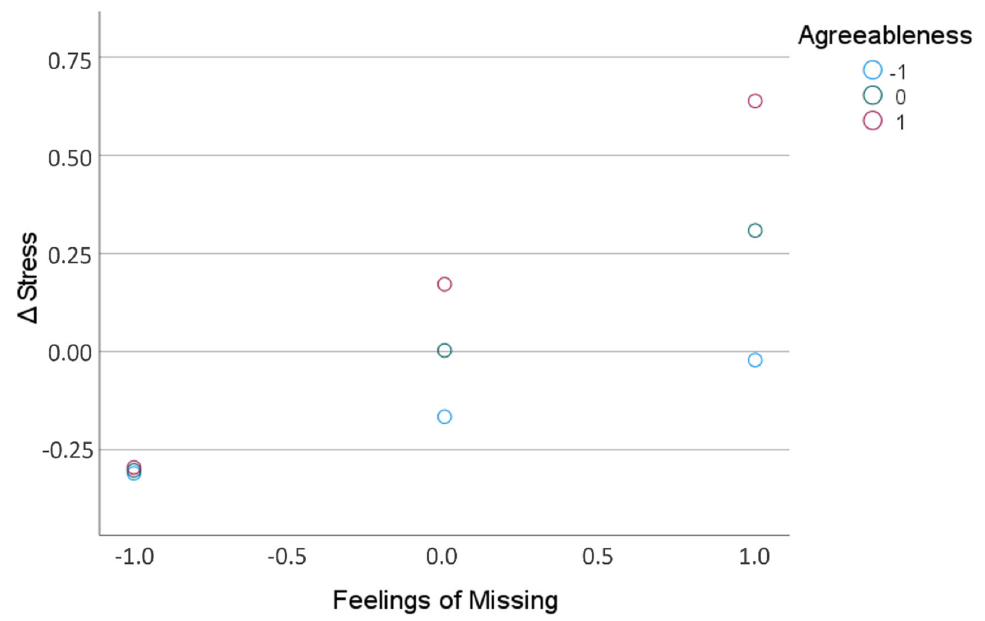
Figure 4. Changes in perceived stress ( ∆ stress) as function of “feelings of missing” for persons scoring relatively high, medium, and low on the big five agreeableness scale.